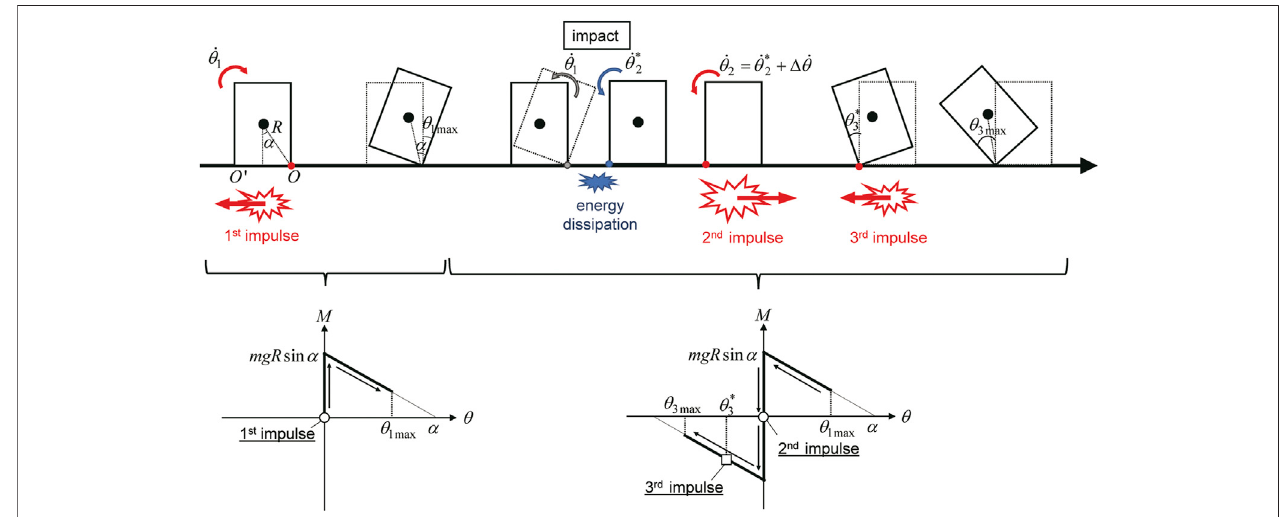
FIGURE 9 | Overview of rocking vibration under triple impulse from the viewpoint of mechanical energy conservation and angular momentum conservation.